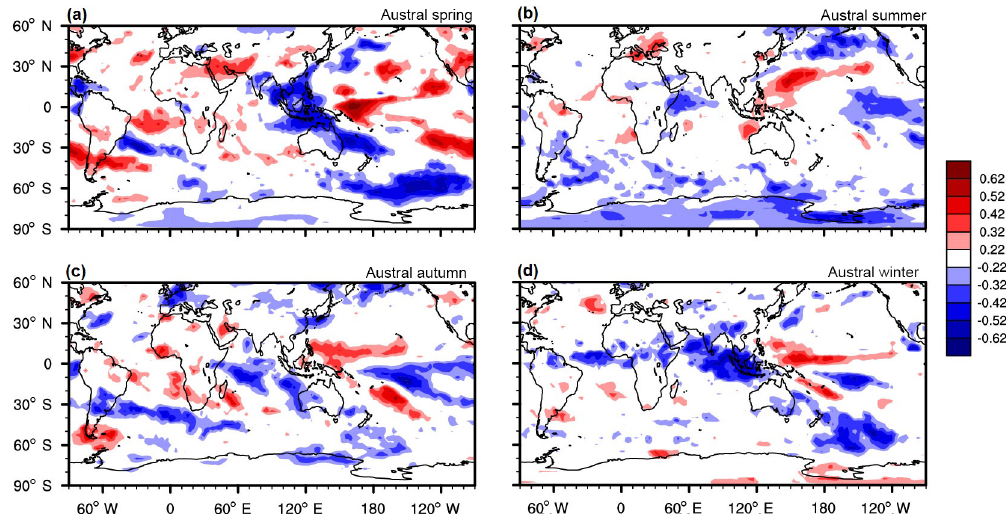
Figure 6. Same as Fig. 5 but between the ST_MSEAI and outgoing longwave radiation from